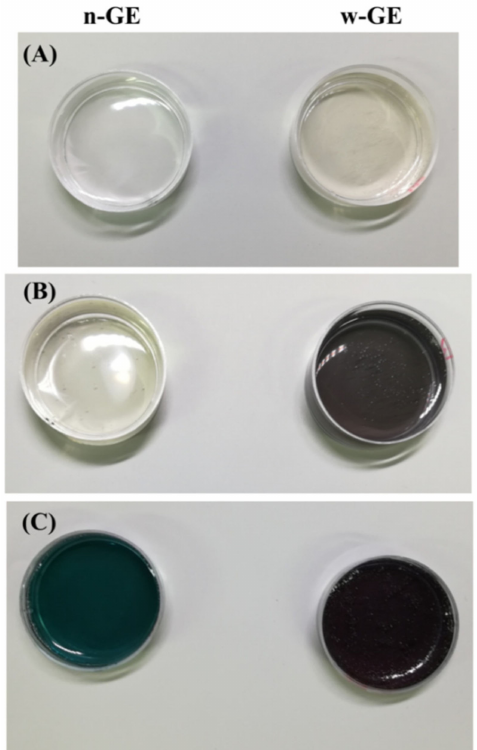
Figure 2. Appearance of CH/genipin solutions immediately after preparation ( A ), after 1 h ( B ), and after 6 h ( C